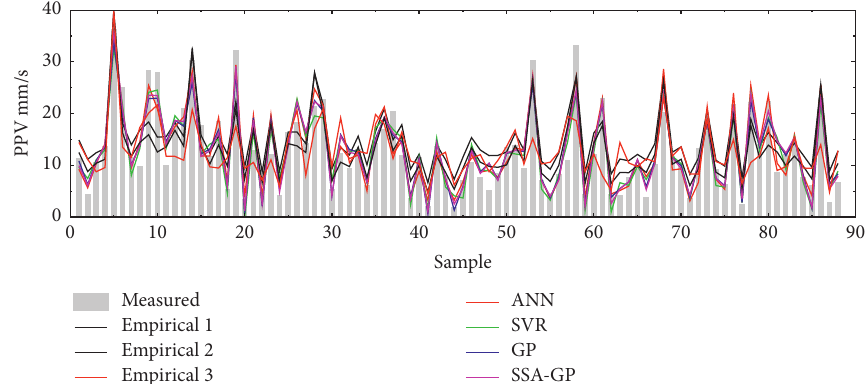
Figure 4: Measured and predicted PPV value obtained from various models.